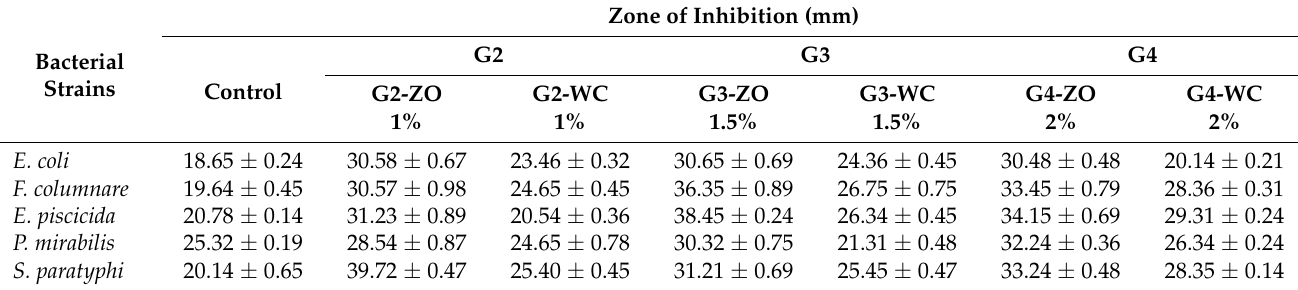
Table 7. Zone of inhibition against the tested bacterial